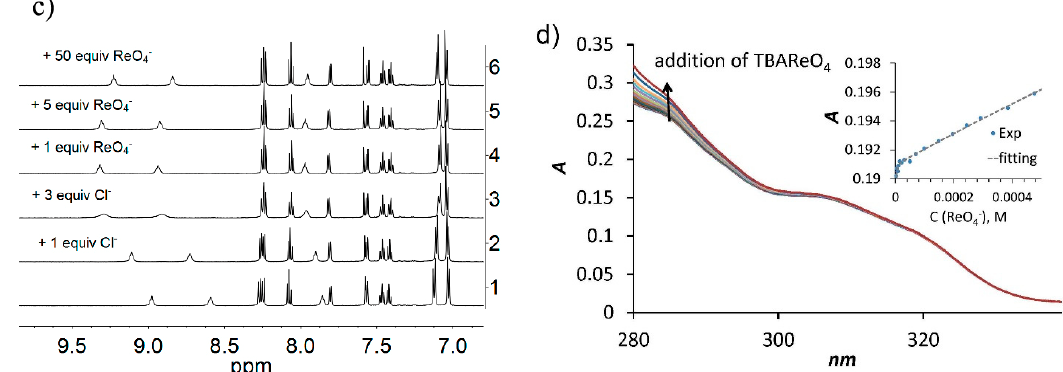
Figure 4. NMR titration of 2 (0.87 mM) with ( a ) TBACl and ( b ) TBAReO 4 . Spectra 1–13 correspond to additions of 0.25, 0.5, 0.75, 1.0, 1.5, 2.0, 2.5, 3.0, 3.8, 4.8, 5.8, 6.7, 7.6, 8.5. and 9.3 equiv. of the anion. ( c ) Competition experiment: addition of 3 eq. of Cl − followed by addition of TBAReO 4. ( d ) UV–Vis titration of receptor 2 with TBAReO 4 . Conditions: 0.01 mM receptor in CD 3 CN (8% CHCl 3 ).